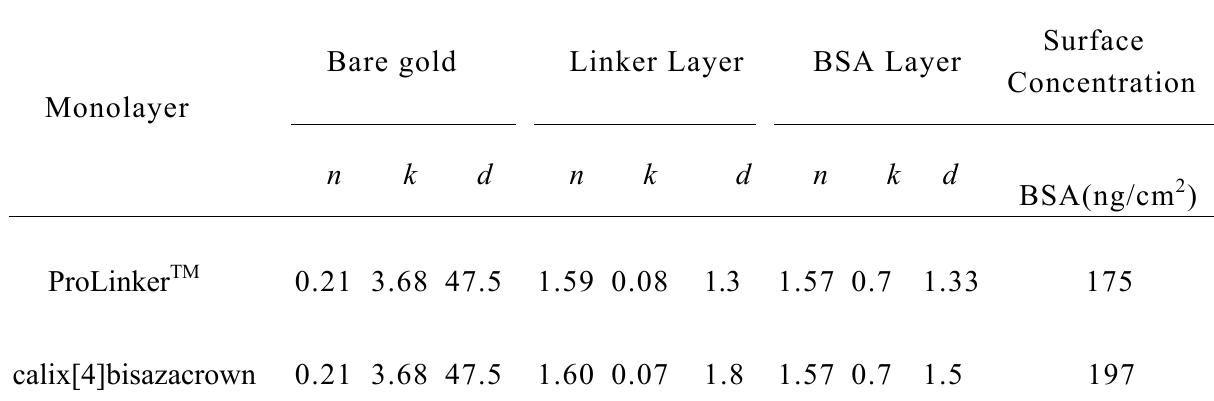
Table 1 . Surface concentration of the immobilized BSA, SAMs and optical parameters determined by theoretical